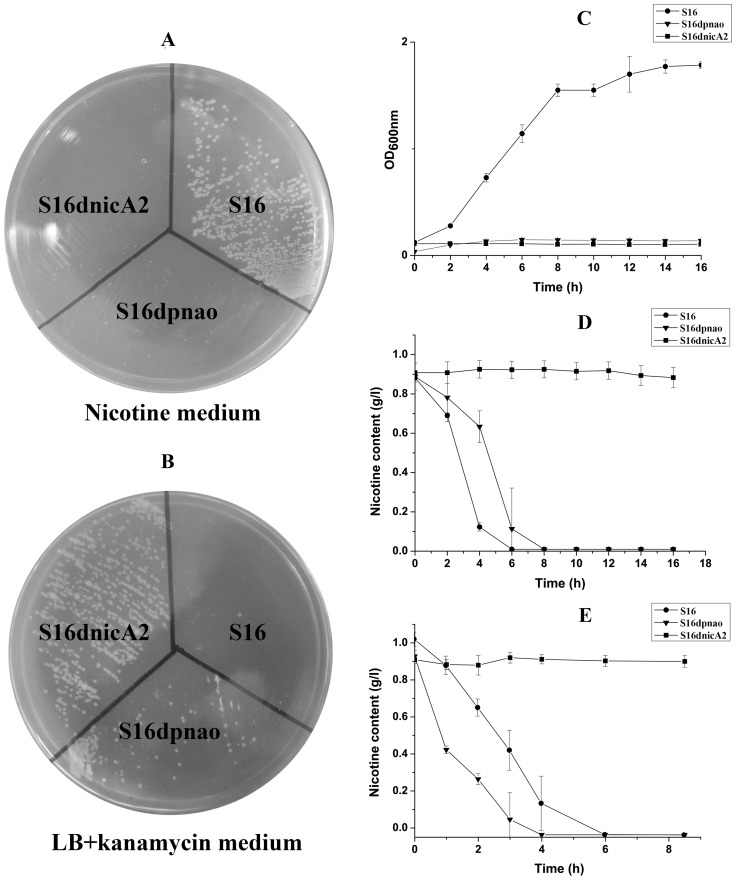
Cell growth and resting cell reactions of strain S16 and the gene deletion mutants.
A. Strain S16 and gene deletion mutants grown on a nicotine plate containing nicotine as the sole carbon and nitrogen source. B. Strain S16 and gene deletion mutants grown on LB plate containing kanamycin. C. Growth curves of S16 (•), S16dpnao (▾), and S16d-nicA2 (▪) with nicotine as sole carbon and nitrogen sources. D. HPLC analysis of nicotine degradation by cell culture of P. putida S16 (•), S16dpnao (▾), and S16dnicA2 (▪). E. HPLC analysis of nicotine degradation by resting cells of P. putida S16 (•), S16dpnao (▾), and S16dnicA2 (▪). The values are means of three replicates, and the error bars indicate the standard deviations.